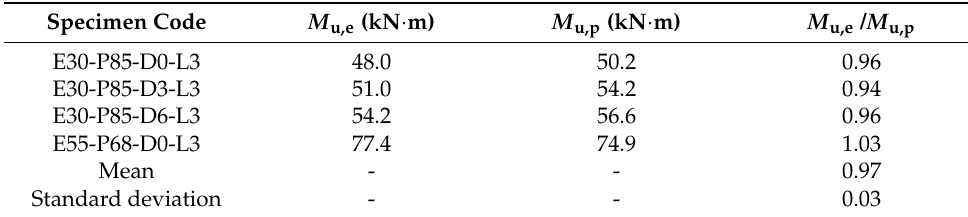
Table 4. The comparison of experimental and predicted